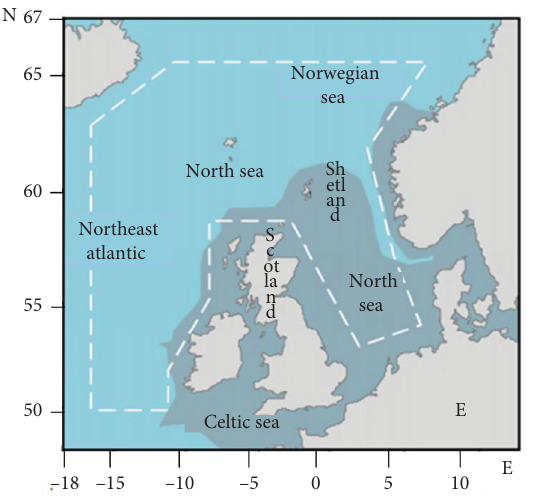
Figure 4: Target research area.